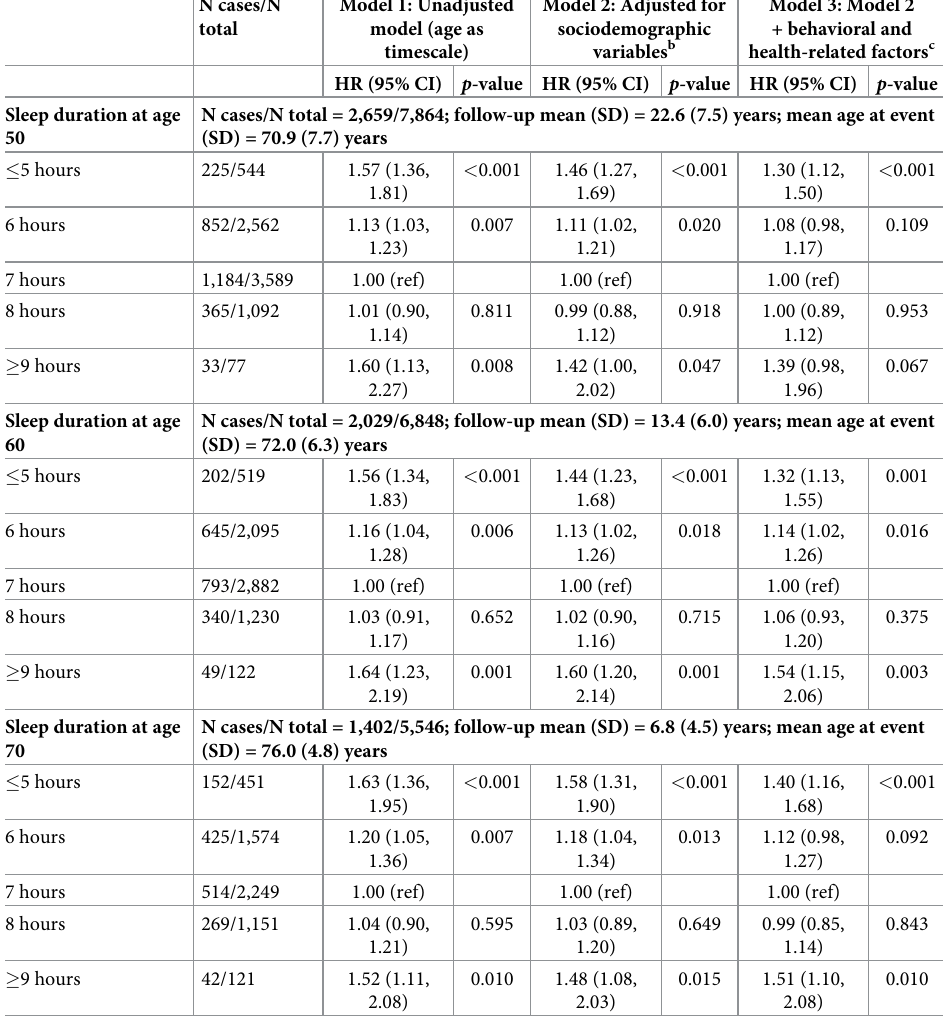
a Multimorbidity defined as 2 or more of the following chronic diseases: diabetes, cancer, coronary heart disease, stroke, heart failure, chronic obstructive pulmonary disease, chronic kidney disease, liver disease, depression, dementia, other mental disorder, Parkinson’s disease, and arthritis/rheumatoid arthritis. b Adjusted for age (timescale), sex, ethnicity, education, occupational position, and marital status. c Additionally adjusted for alcohol consumption, physical activity, smoking status, fruit and vegetable consumption, BMI, hypertension, use of sleep medication, and prevalence of 1 of the 13 chronic diseases. CI, confidence intervals; HR, hazard ratio; ref, reference; SD, standard